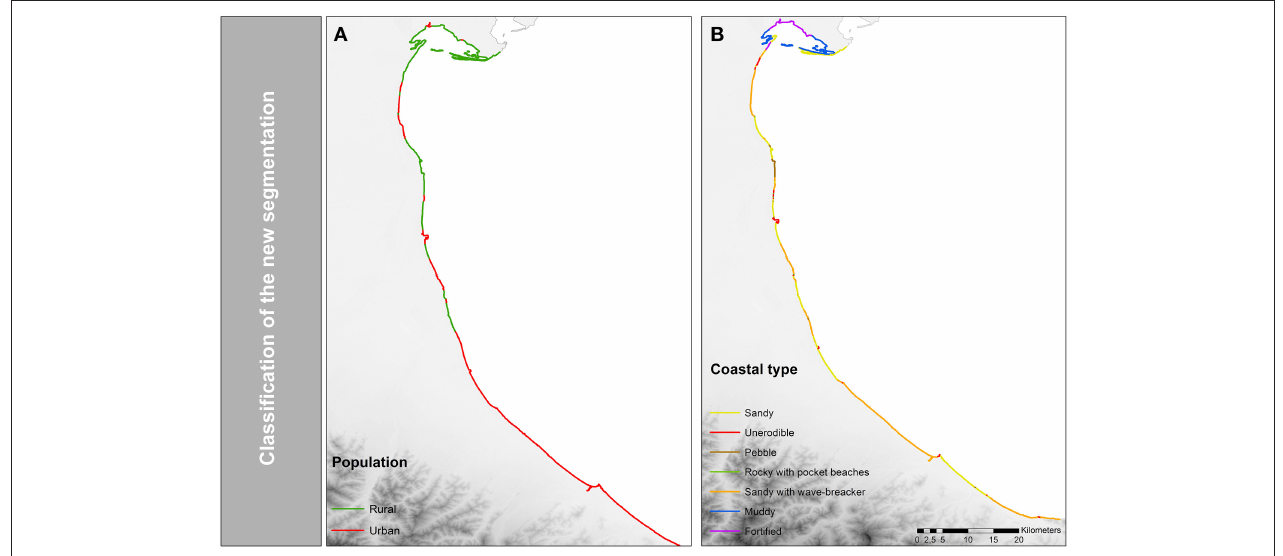
FIGURE 5 | Results of the high-resolution segmentation model. (A) Coastal settlements. (B) Coastal typology